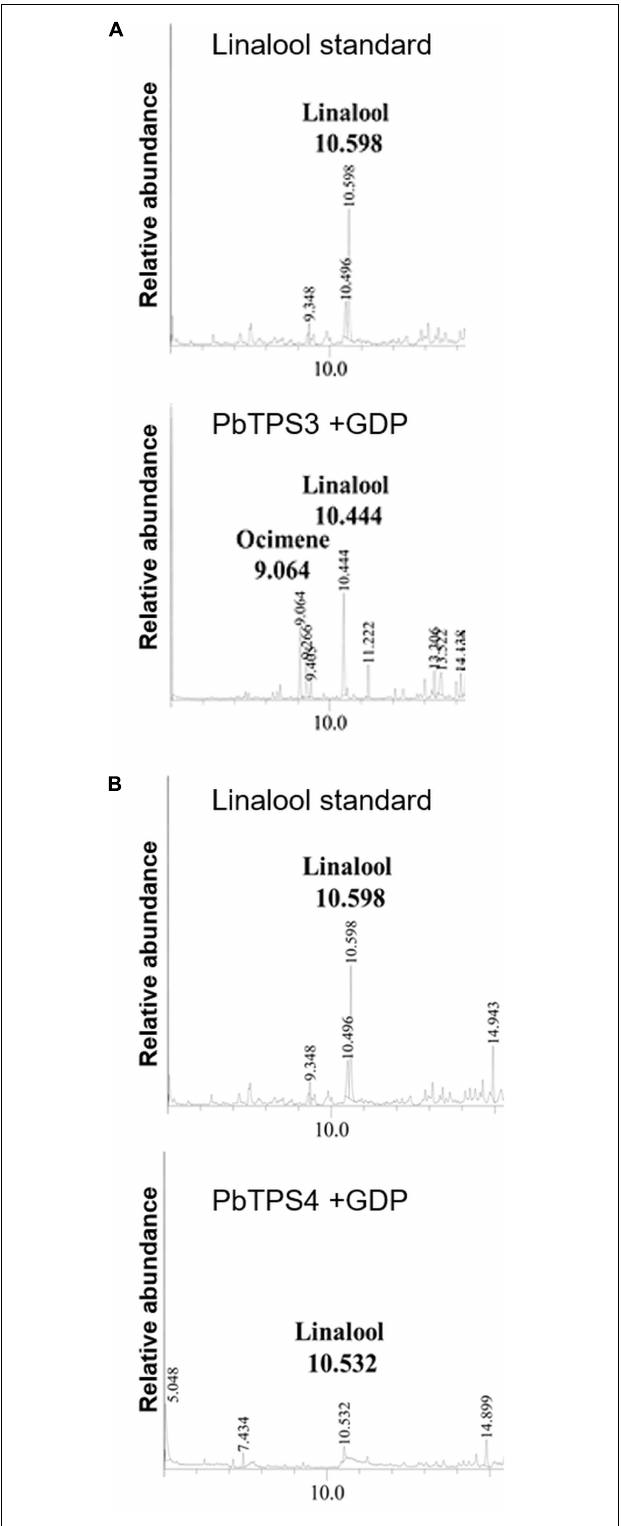
FIGURE 6 | Functional characterization of purified recombinant protein of (A) PbTPS3 + GDP and (B) PbTPS4 + GDP. GC-MS analysis of authentic linalool standard incubated with enzyme assay